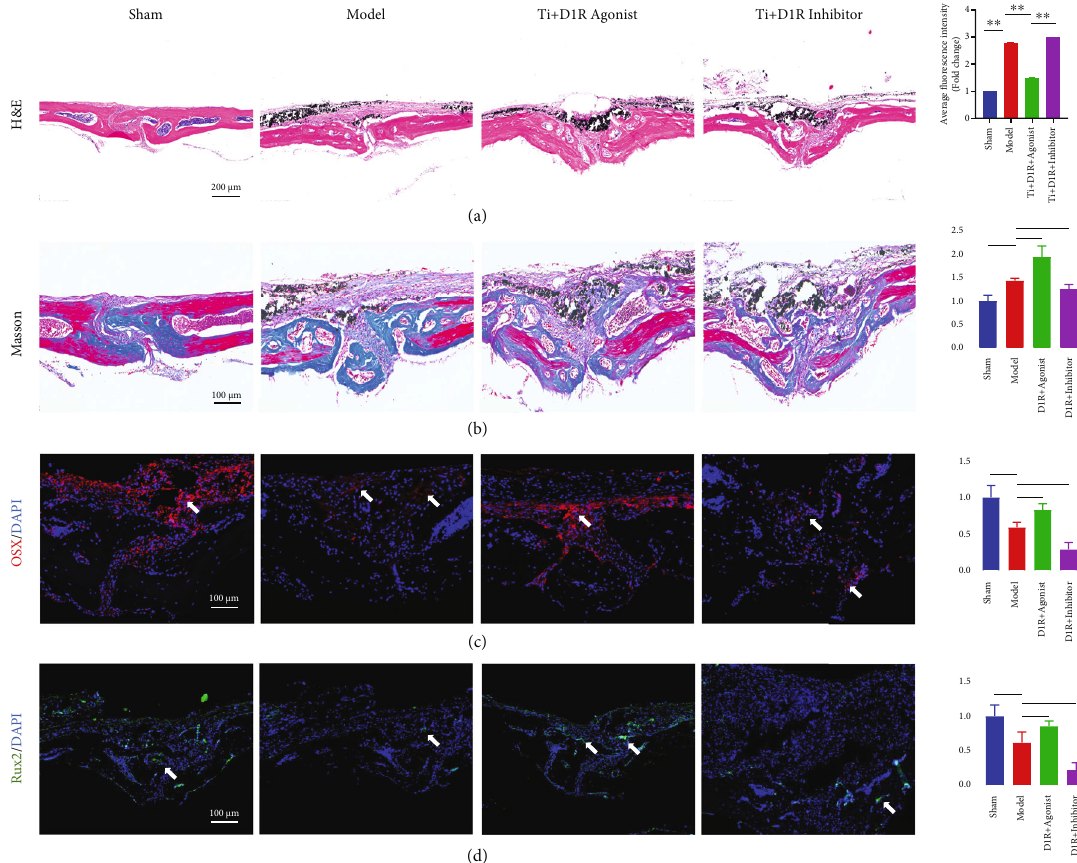
Figure 7: Activating D1R relieves mouse osteolysis caused by titanium particles and relieves osteogenesis inhibition. (a, b) Representative para ffi nized sections were stained with H&E and Masson ’ s trichrome staining and their quanti fi cation. (c, d) Representative images and quantization showing immuno fl uorescence staining of the osteoblast-related proteins OSX and Runx2 in skull sections of mice in the sham group, model group, D1R agonist group, and D1R inhibitor